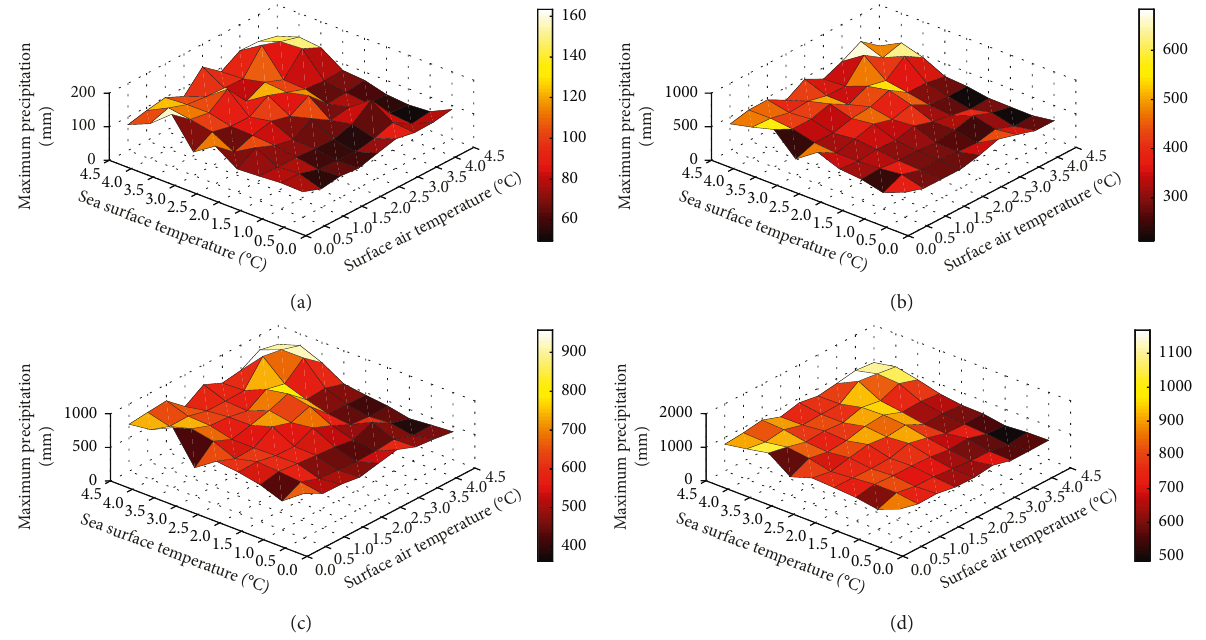
Figure 8: MP for duration (a) 1 hour, (b) 6 hours, (c) 12 hours, and (d) 24 hours at